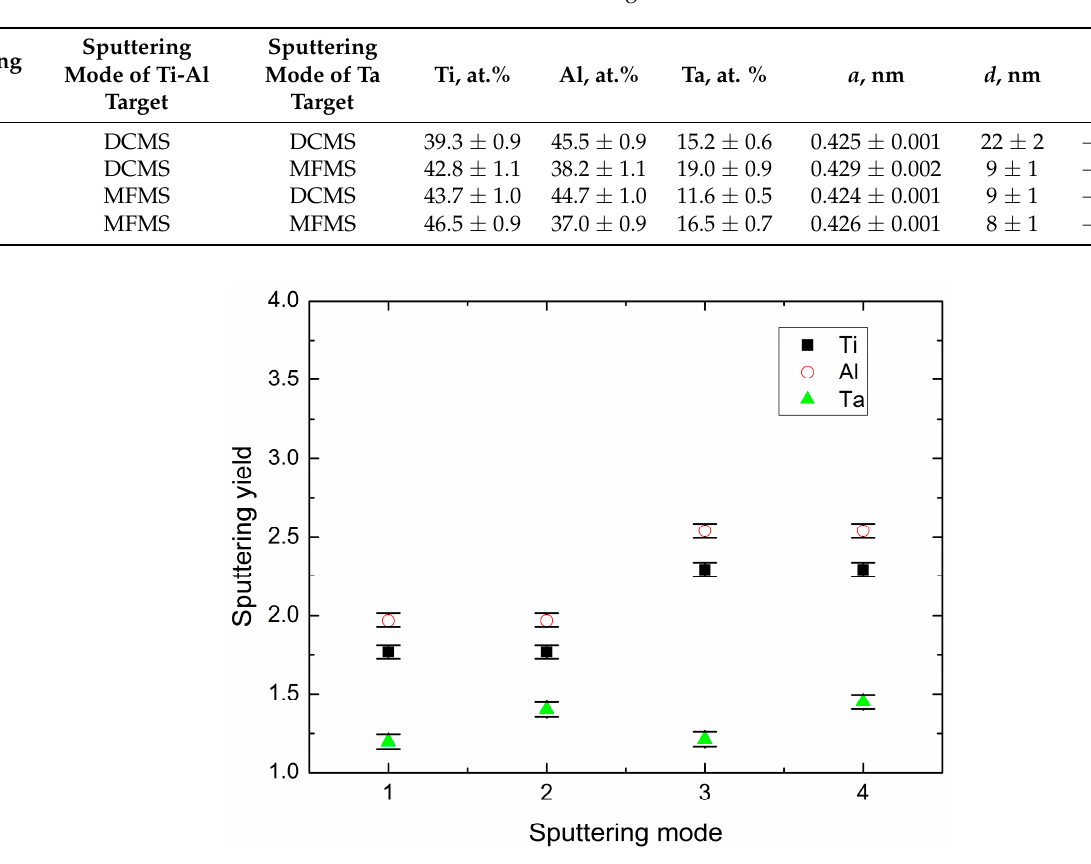
Table 1. Chemical composition, lattice constant, average size of coherently diffracting domains and residual stresses in the Ti-Al-Ta-N coatings.